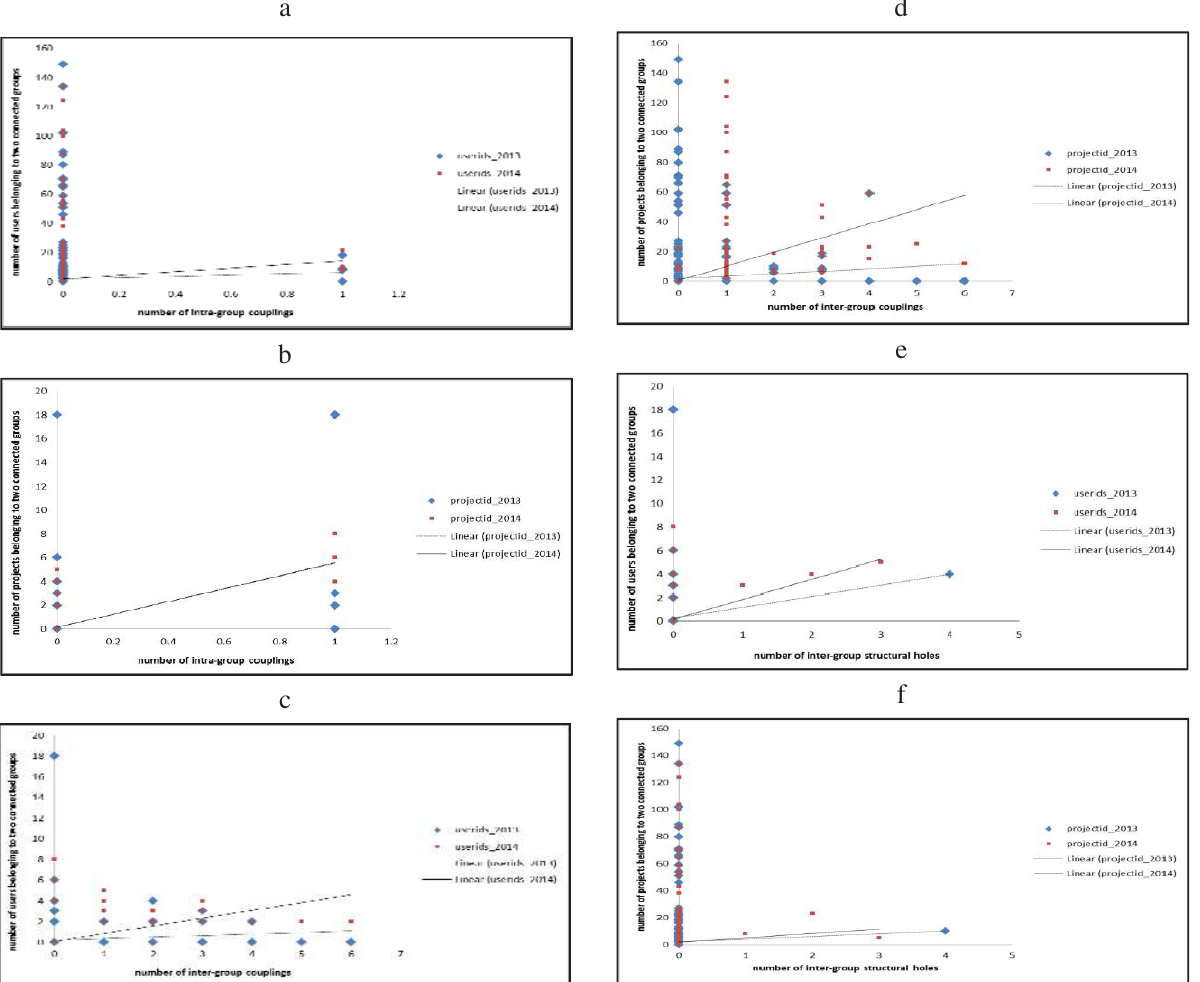
Fig. 6. Illustration of growth and innovation as results of intra-, inter-group couplings and structural